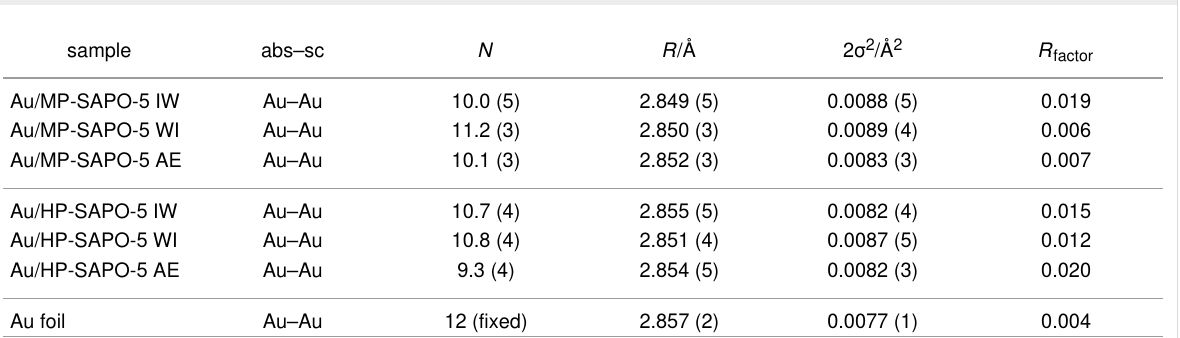
Table 1: XAS fitting paths of Au-doped SAPO systems and Au foil. a